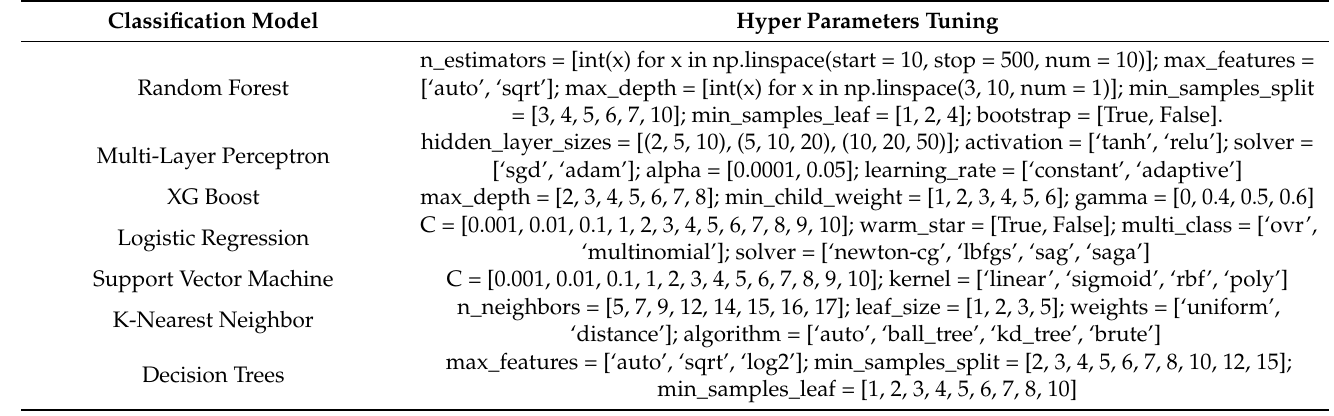
Table 7. Hyper parameter settings for tuning the ML algorithms.